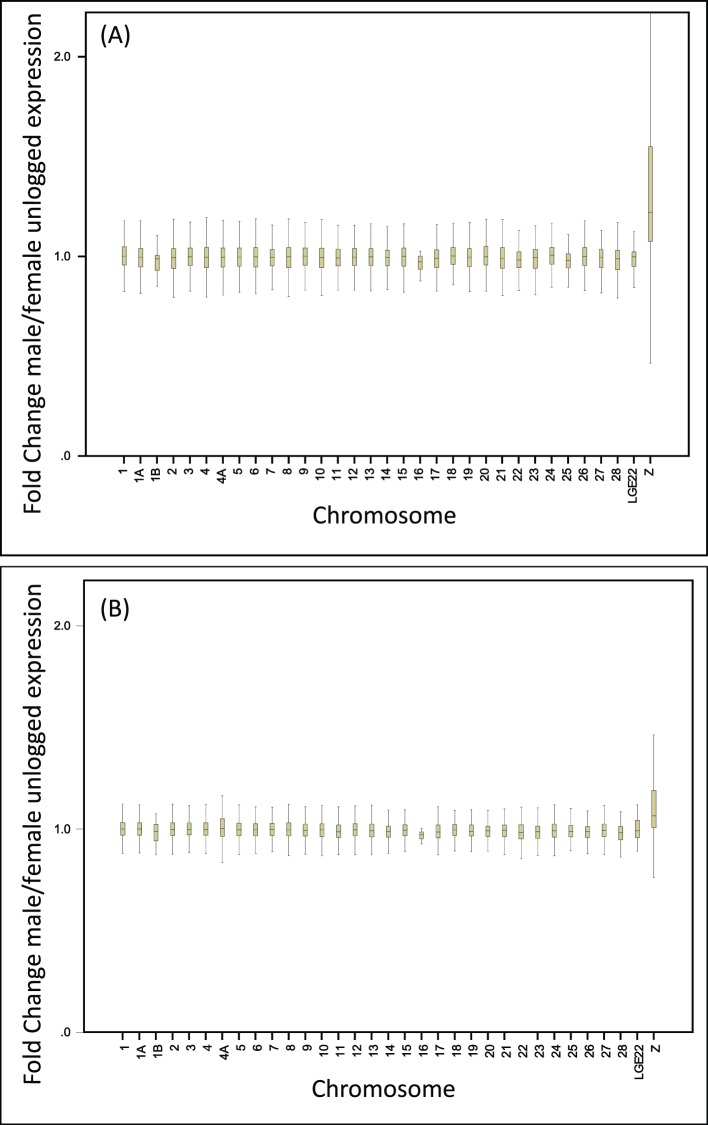
Box plot of Fold Change (i.e. male/female intensity) for individual chromosomes for the zebra finch (A) and the common whitethroat (B).